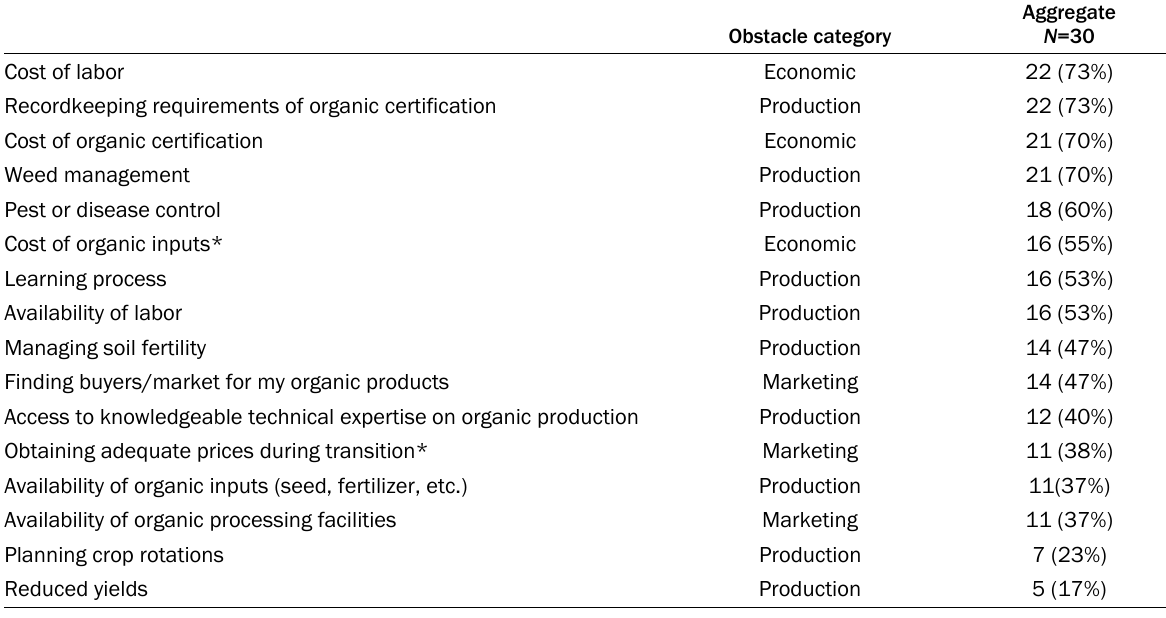
Table 6. Ranked Obstacles to Organic